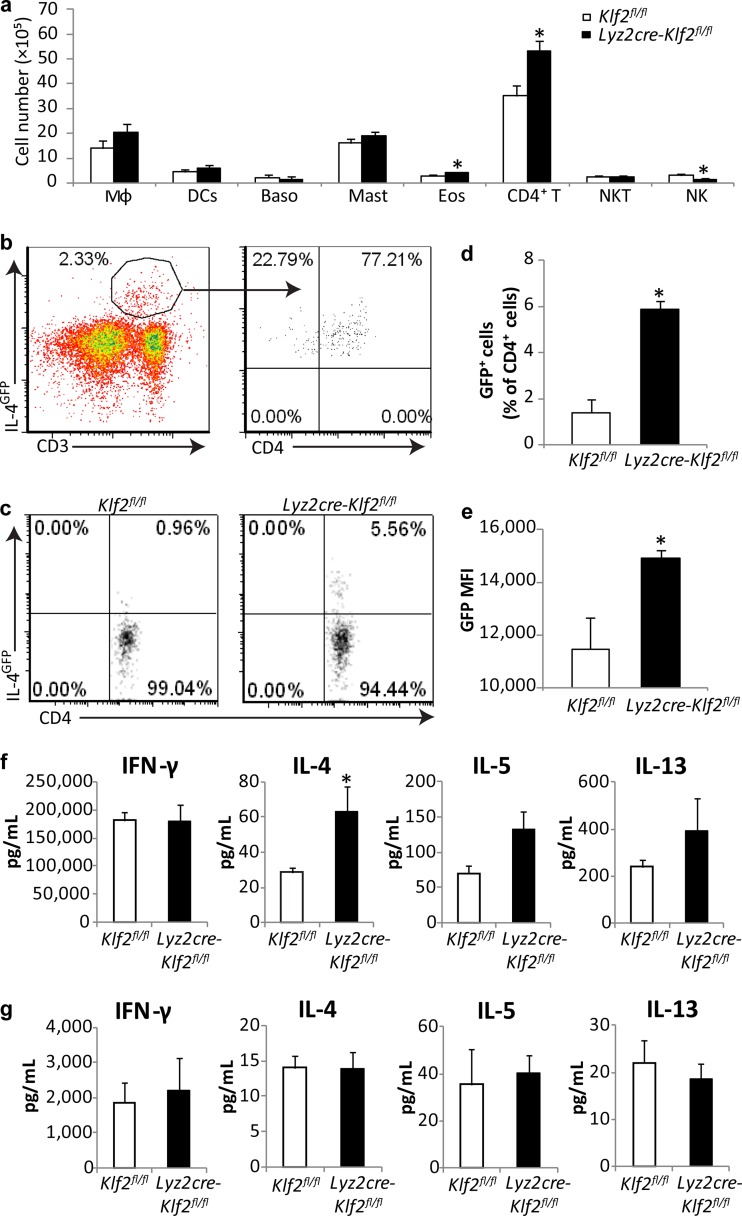
Myeloid KLF2 deficiency enhances Th2 responses in H. capsulatum-infected mice. (a) IL-4-producing cells in the lungs at day 14 p.i. were captured by IL-4 secretion assay (n = 4 or 5). Cell profiles are described in Materials and Methods. Baso, basophils; Mast, mast cells; Eos, eosinophils. (b to e) Percentages and MFI values of IL-4GFP+ cells in the lungs at day 14 p.i. (n = 5). (f and g) Th1/Th2 cytokine production by CD4+ cells (f) or CD4− cells (g) isolated from the lungs at day 14 p.i. and restimulated for 24 h ex vivo (n = 4 or 5). *, P < 0.05, and **, P < 0.01, for comparison with the results for control mice by t test. Data represent the mean results ± SEM.